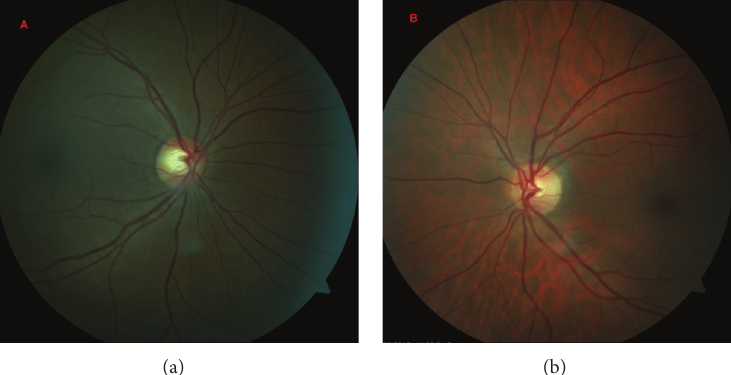
Figure 5: Fundus photography of the right eye (a) shows “darker fundus” (more pigment in the choroid) by ophthalmoscopy. The physical appearance of the right optic disc shows signs of glaucoma (C/D 0.4). Fundus photographs of the left eye (b), and optic head nerve is normal (C/D 0.2).